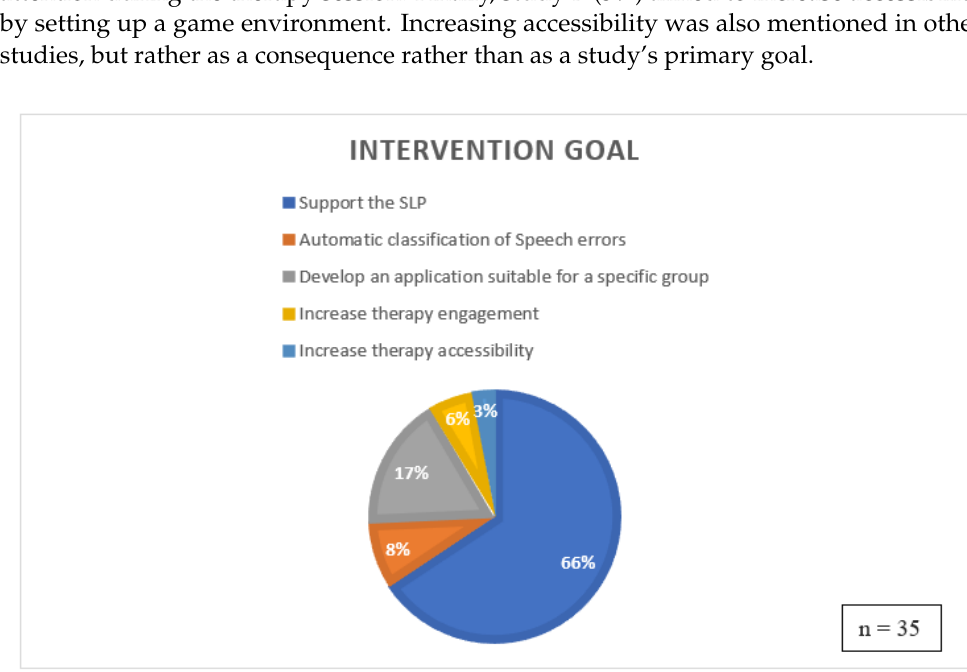
Figure 2. Intervention goal OST